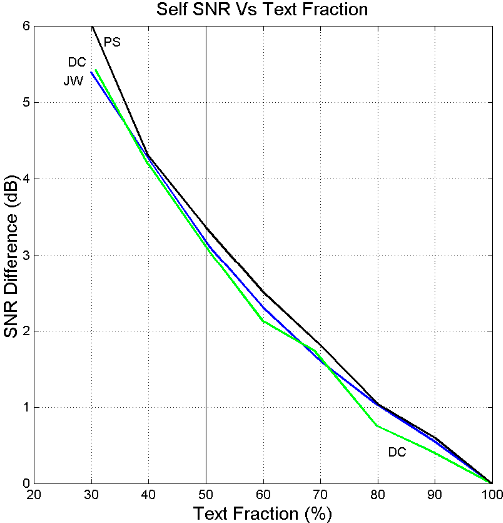
Figure 15. Difference between the average signal-to-noise ratio obtained with full text (100%) and that obtained with reduced text in the sentences self-channel in Jewish War (JW, blue line), David Copperfield (DC, green line), and I Promessi Sposi (PS, black